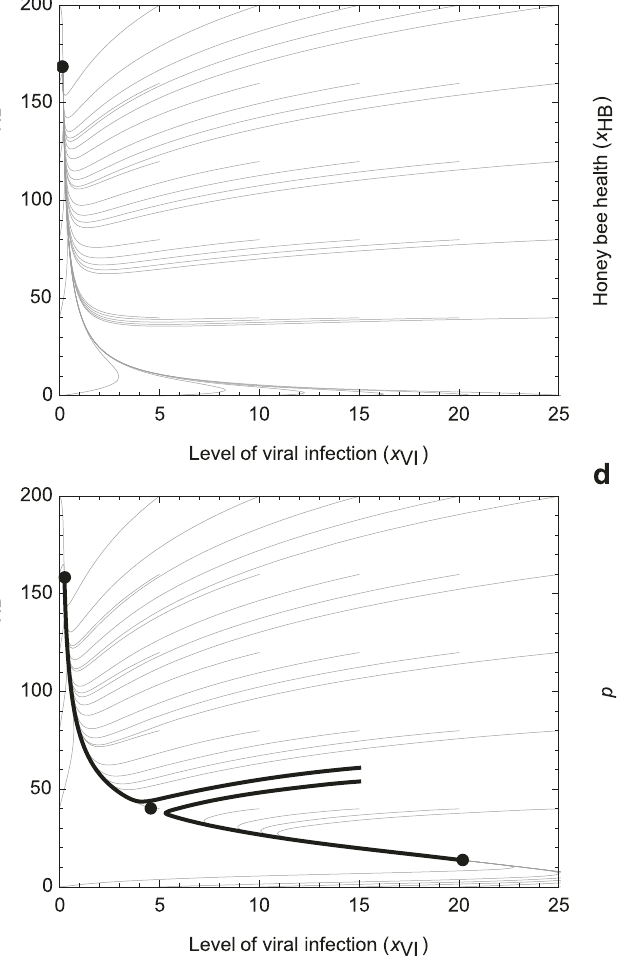
Fig. 2| Theequilibriaand someorbitsof thefullsystemintheprojectedphase plane of honey bee health ( x HB ) and level of viral infection ( x VI ). Equilibria represent the values of the state variables where they do not change and are indicated with dots, while the orbits are the values that the state variables can assume while approaching the equilibria and are represented with lines. a Orbits andtheuniqueequilibriumwithoutimmune-suppression,inpresenceofalowlevel of parasites. b Orbits and the unique equilibrium without immune suppression, in